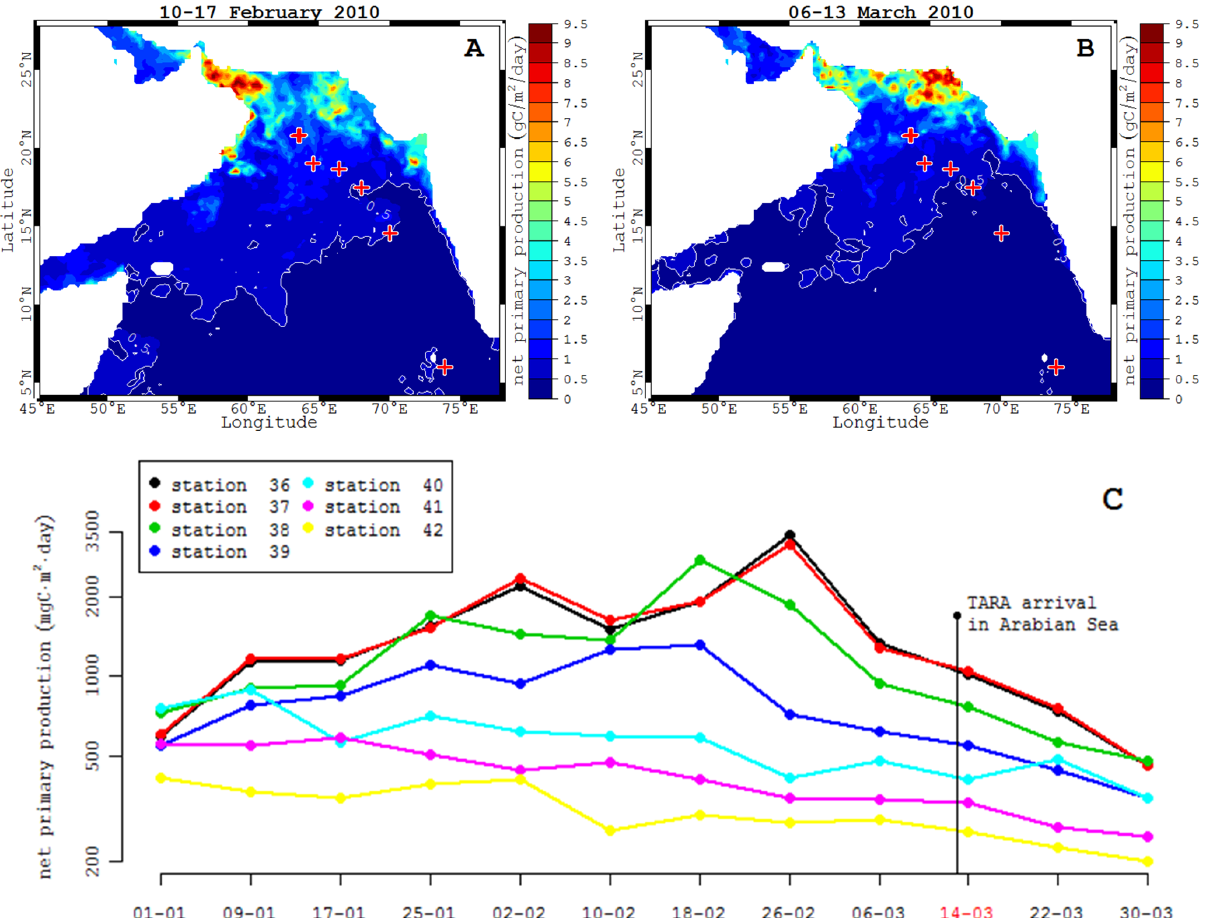
Figure 3. Maps of net primary production before (10–17 February 2010, A ) and during (6–13 March 2010, B ) the arrival of the TARA vessel in the Arabian Sea. Colours represent location of the stations. (C) weekly average net primary production before the cruise and the week during the cruise (year